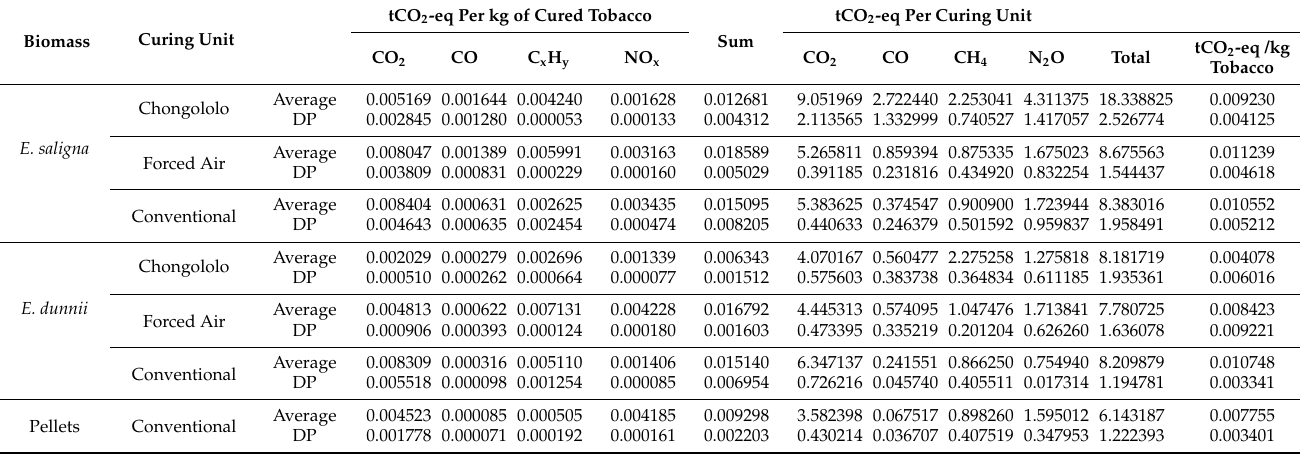
Table A3. Emission factors in tonnes of carbon equivalent per kg of dried tobacco and per curing